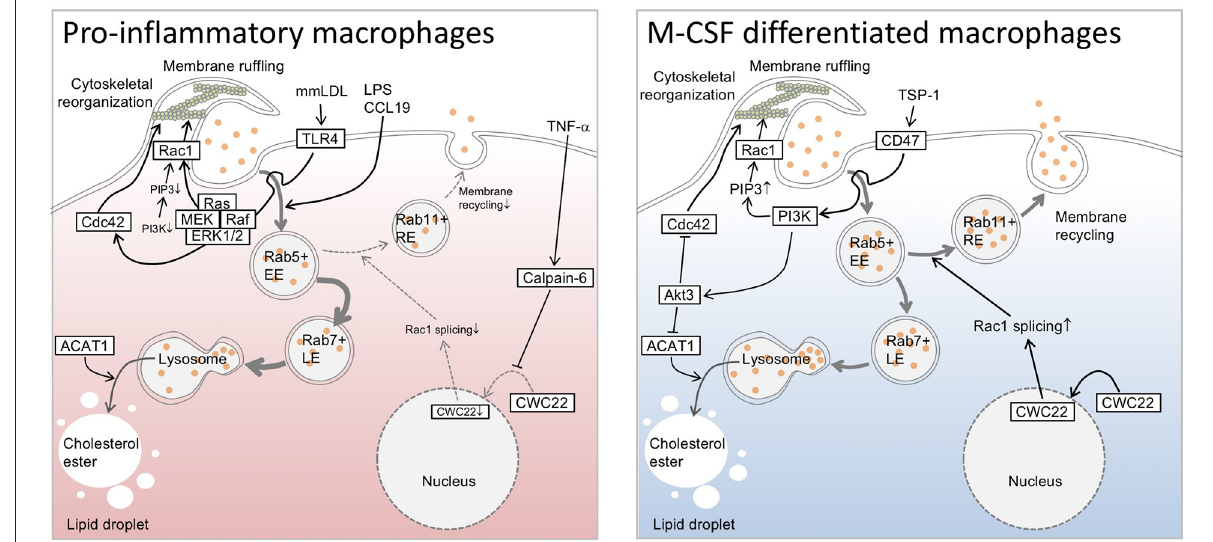
FIGURE1 Overview of pinocytotic deposition of low-density lipoprotein cholesterol in macrophages. Phosphoinositide 3-kinase drives pinocytotic plasma membrane ruffling. Small GTPases are associated with trafficking and recycling of pinosomes, as well as with pinocytotic plasma membrane regulation, and have diverse actions in pinocytotic low-density lipoprotein cholesterol uptake in macrophages. While pinocytosis appears to be optimized in an alternative (M2) macrophage subset, certain elements, such as Toll-like receptor 4 (TLR4)-mediated signaling, enable the restoration of pinocytosis, even in an inflammatory (M1) subset. TLR4 driver lipopolysaccharide (LPS) can polarize macrophage differentiation toward M1 subset, and activates pinocytotic activation through unknown mechanisms. Chemokine (C-C motif) ligand 19 reportedly possesses similar pinocytotic effects in the cells. In the case of mmLDL-differentiated macrophages, cytoskeletal rearrangement appears to be driven through TLR4/Ras/Raf/ERK/MEK axis independently of PI3K signaling. Furthermore, pro-inflammatory cytokine TNF- α upregulates calpain-6, a non-proteolytic isoform of calpain protease family, to inhibit CWC22-mediated Rac1 splicing. This interferes with endosomal recycling pathway, and in turn increases lysosomal processing of endosome-derived lipoprotein cholesterol to generate cytosolic lipid droplets. In contrast to